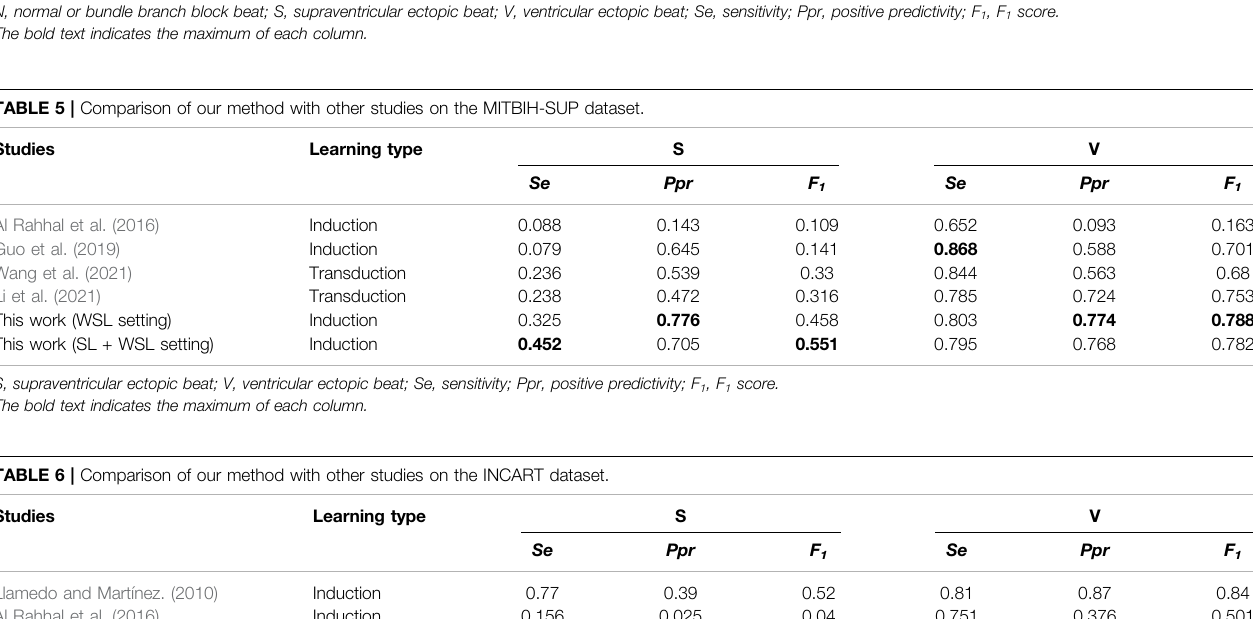
Al Rahhal et al. (2016)